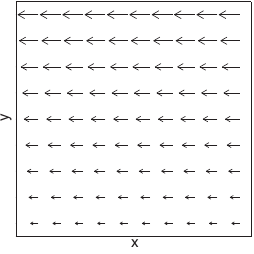
FIG. 4. Pretest field 1.